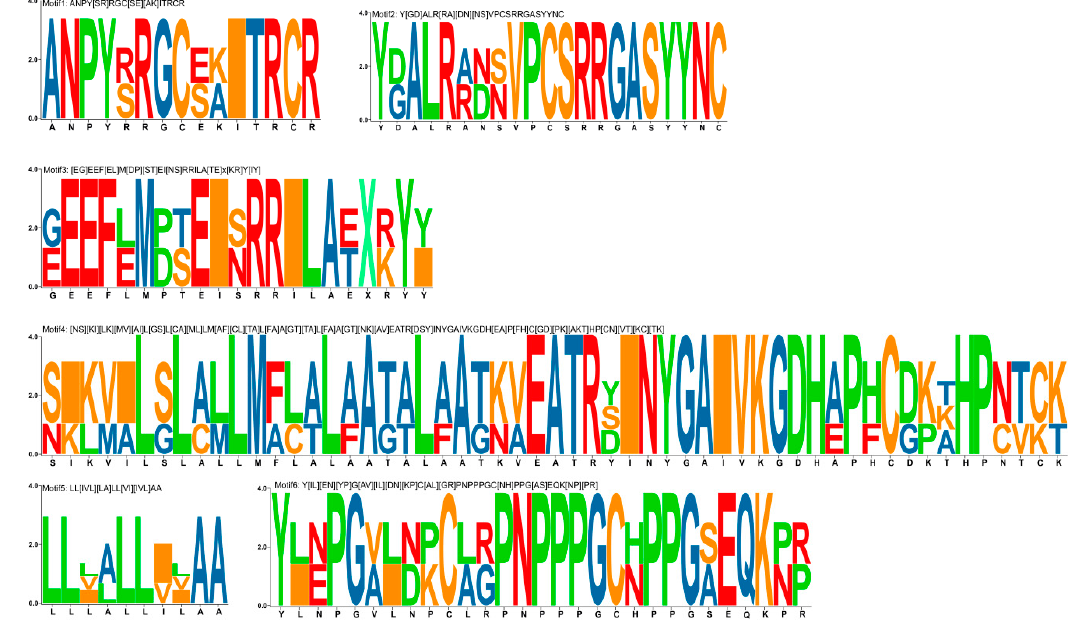
Figure 2. The six motifs in the research.